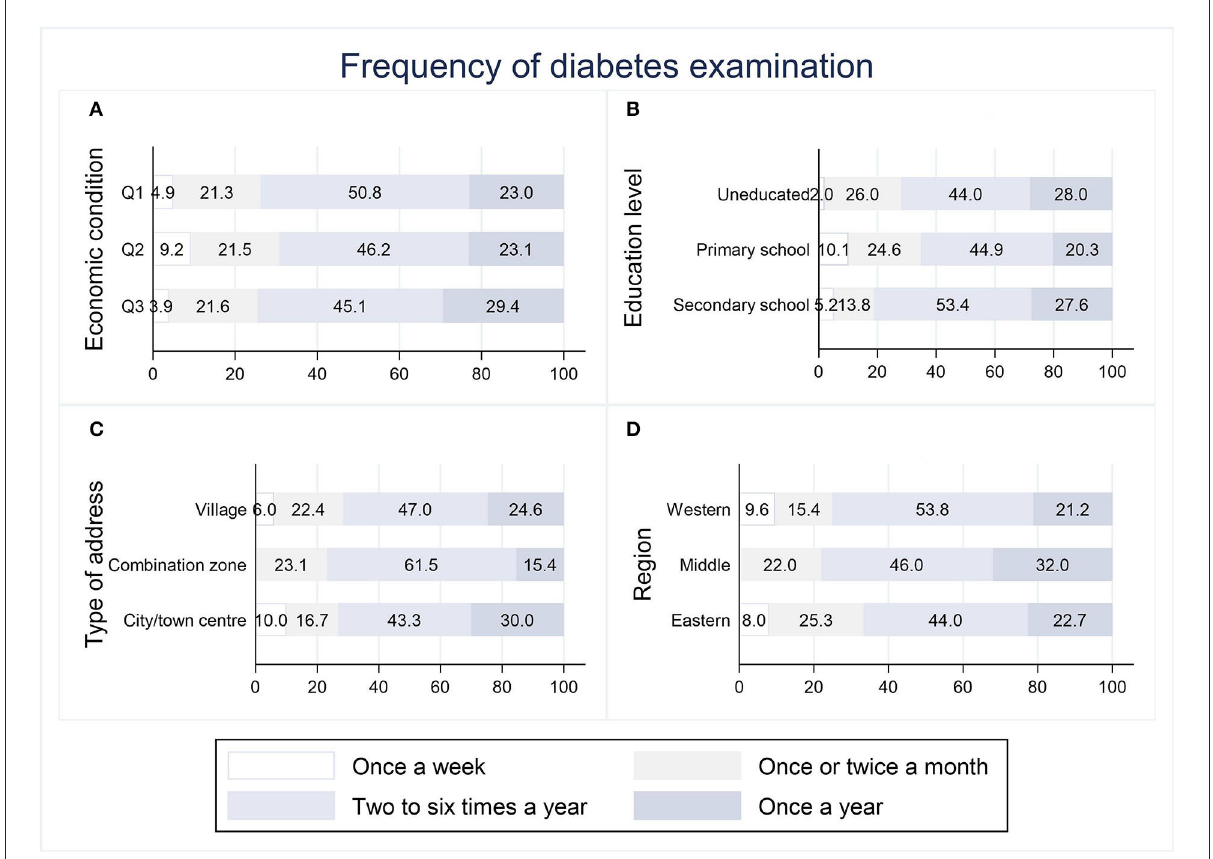
FIGURE4 Distribution of frequency of community-based diabetes